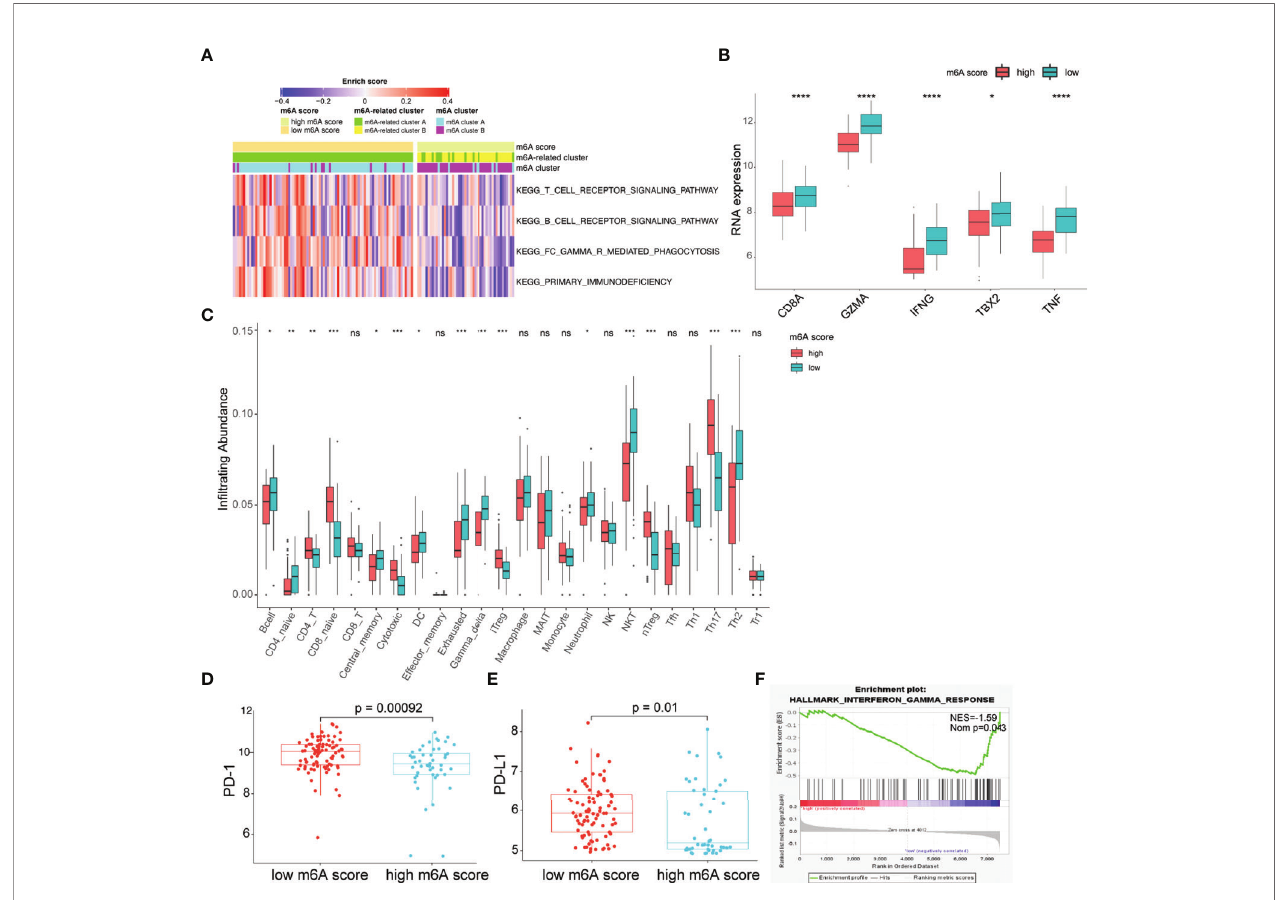
FIGURE 5 | Characteristics of the TME between the high and low m6A score groups. (A) Heatmap showing differences in the immune-associated biological pathways between m6A score groups (adjusted p-value<0.05). (B) Differences in in fl ammatory/immune response-associated genes between m6A score groups. (C) Differences in the relative abundance of in fi ltrating immune cells between m6A score groups. (D, E) Differences in the expression of PD-1 (D) and PD-L1 (E) between m6A score groups. (F) The interferon-gamma response is enriched in the low m6A score group by GSEA. TME, tumor microenvironment; NES, normalized enrichment score; NOM p, nominal p-value; NS, not signi fi cant; *p < 0.05; **p < 0.01; ***p < 0.001; ****p <